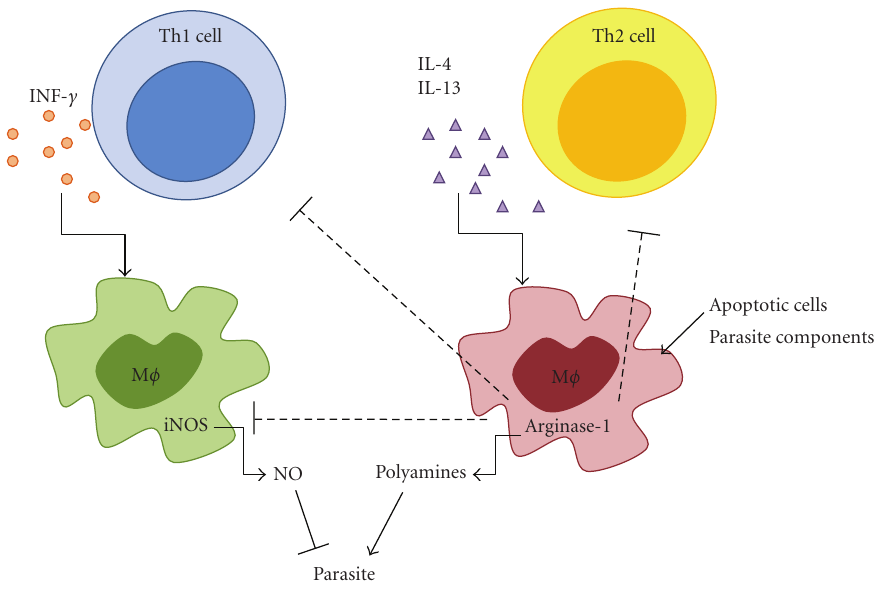
Figure 1: Role of macrophage activation in parasitic infections. A type 1 cytokine-dependent proinflammatory response inducing classically activated macrophages (CaM φ s) leads to NO production and also to the synthesis of several products of NO reaction. CaM φ s are crucial for parasite control during protozoan infections but can also contribute to the development of immunopathological disease symptoms. Type 2 cytokines such as IL-4 and IL-13 antagonize CaM φ s inducing alternatively activated macrophages (AaM φ s) that upregulate arginase-1 expression. Arginase-1 can also be induced during the infection by apoptotic cells or even directly by parasites or parasite components. Arginase-1 limits CaM φ -dependent parasite clearance promoting parasite proliferation. Additionally, arginase-1 suppresses T cell response. Therefore, generation of alternative activation states of macrophages could limit collateral tissue damage because of excessive type 1 inflammation. However, they a ff ect disease outcome by promoting parasite survival and proliferation.